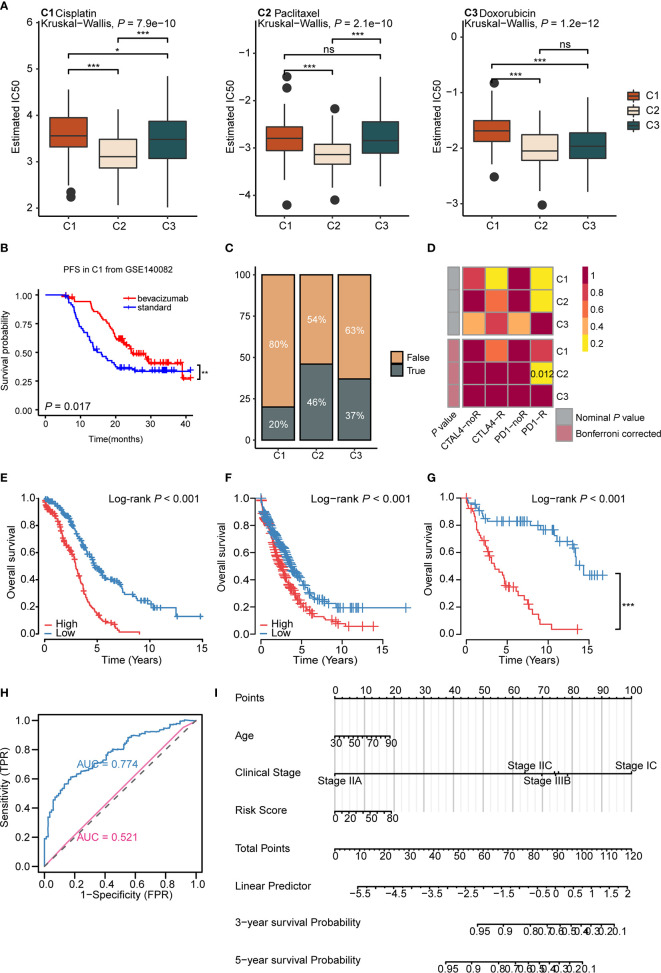
Immunometabolism subtypes could predict the treatment efficacy and survival of ovarian cancer patients (A) The boxplots of the estimated IC50 for cisplatin, paclitaxel, and doxorubicin for three subtypes based on GDSC database. P values were calculated using Kruskal-Wallis test for three subtypes. (B) Kaplan-Meier curves of progression free survival (PFS) for bevacizumab versus standard treatment stratified in C1 from GSE140082 (P < 0.05). (C) The predicted response rate of immunotherapy (TRUE/FALSE) to anti-PD-L1 among three subtypes in the TCGA ovarian cancer cohort. Fisher exact test, P < 0.001. (D) Submap analysis of the response to PD-L1 inhibitor among three subtypes. (Bonferroni corrected P value: 0.012). (E–G) Kaplan-Meier curves of OS for high and low risk score group in the TCGA ovarian cancer cohort (E), validation cohort 1 (F), validation cohort 2 (G). (H) ROC curves measuring the predictive value of risk score and clinical stage. The area under the ROC curve was 0.774 and 0.521 for the risk score and clinical stage, respectively. (I) The nomogram for predicting probability of survival at 3 and 5 year in patients. (*P < 0.05; **P < 0.01; ***P < 0.001, ns
P > 0.05).